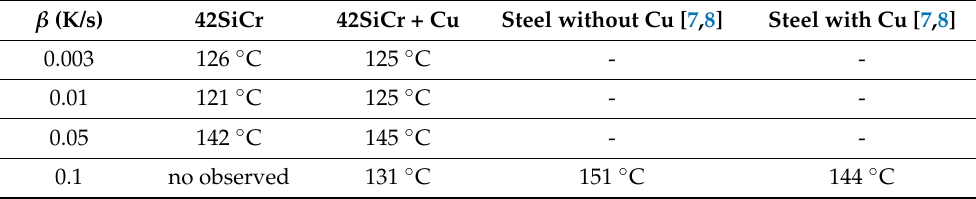
Table 2. Temperatures corresponding to inflection points ( T i ) at different heating rates ( β ) for stage I of tempering in the dilatometry